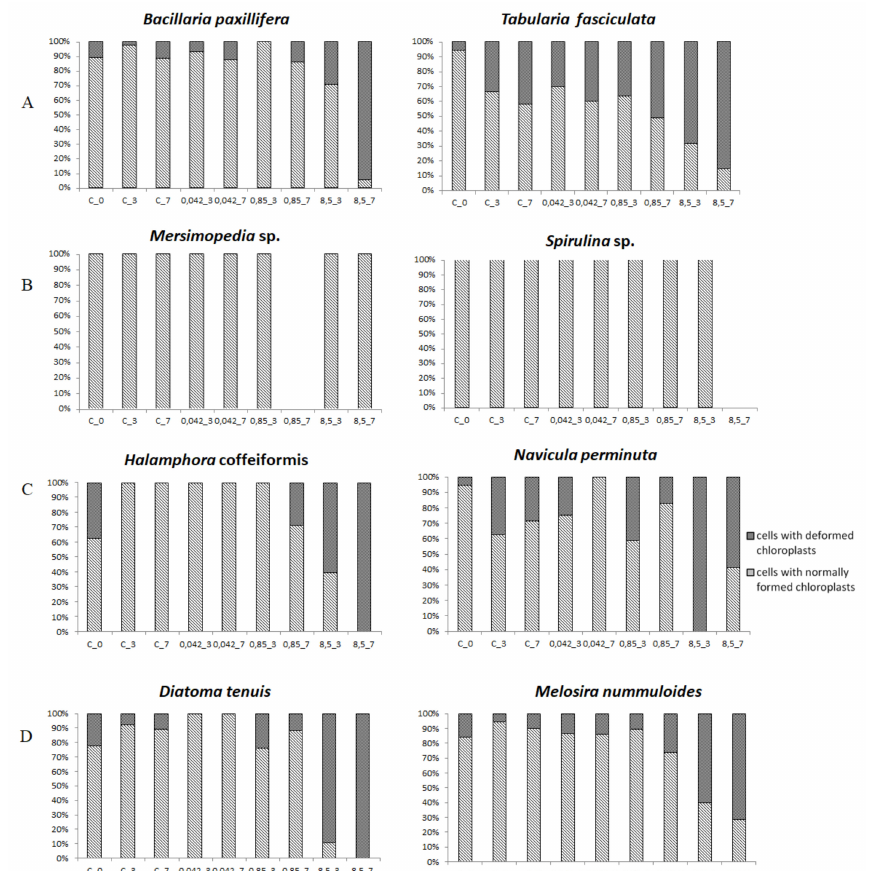
Figure 5. Changes in the condition of selected species expressed as the percentage share of cells with normal chloroplasts and abnormal chloroplasts in the control solution ( C ) and in the tested glyphosate solutions (0.042 g · dm − 3 , 0.85 g · dm − 3 , and 8.52 g · dm − 3 ) at the start of the experiment and after three and seven days of the tests. ( A )—dominant species on which glyphosate had a negative effect on growth, ( B )—cyanobacteria in which glyphosate stimulated growth selectively, C—resistant species on which glyphosate had a positive effect on abundance, ( D )—sensitive species on which glyphosate had a negative effect on